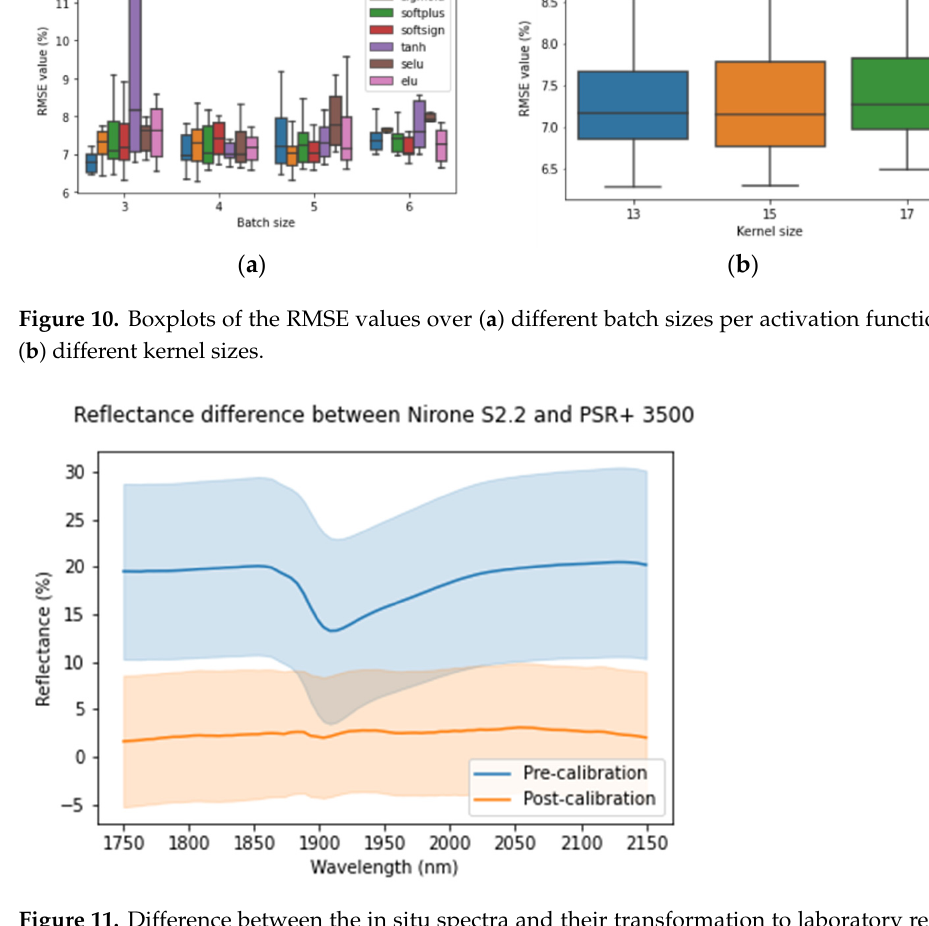
Figure 10. Boxplots of the RMSE values over ( a ) different batch sizes per activation function, and ( b ) different kernel sizes.